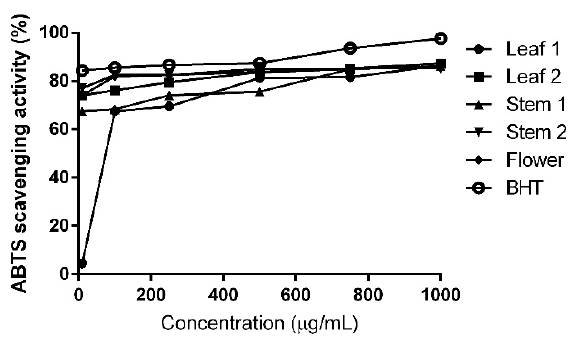
Figure 2: ABTS radical scavenging activity of M. sativa L. extracts at different growing period and standard compound